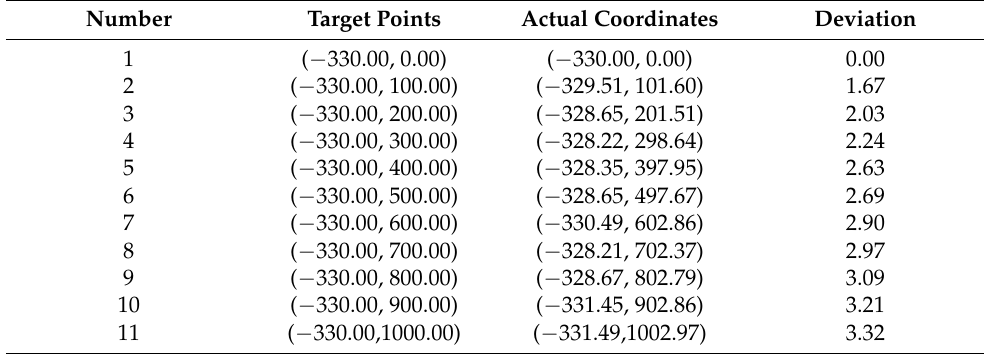
Figure 16. Scenario simulation build. ( a ) Map of the test scenario, ( b ) SLAM-gmapping 2D maps. First, the map building command was issued on the IPC, and the launch file of Gmapping was run in ROS autonomously to build a 2D map of the test environment, as shown in Figure 16b, where the small black dots represent the actual locations of the fruit trees constructed by Laser Radar. Ten targets were set on the map according to their actual distance from the test site. After that, the IPC issued navigation commands, and the robot applied the AMCL positioning algorithm with the combined improvement A* and DWA navigation algorithms to navigate along a straight line. A total of 200 linear navigation tests were conducted, and the coordinates of the target points passed by the robot during each test were recorded. The walking coordinates of each target point were averaged, and their deviation from the target point was determined. After each test, the robot was placed in the same initial position to avoid other factors affecting the test results and to ensure test independence. The test scenario and 2D raster diagram are shown in Figure 16. The test results are listed in Table 1, where the deviation between the target point and the actual coordinate is calculated as shown in Equation (25). Table 1. Straight travel test data Unit: